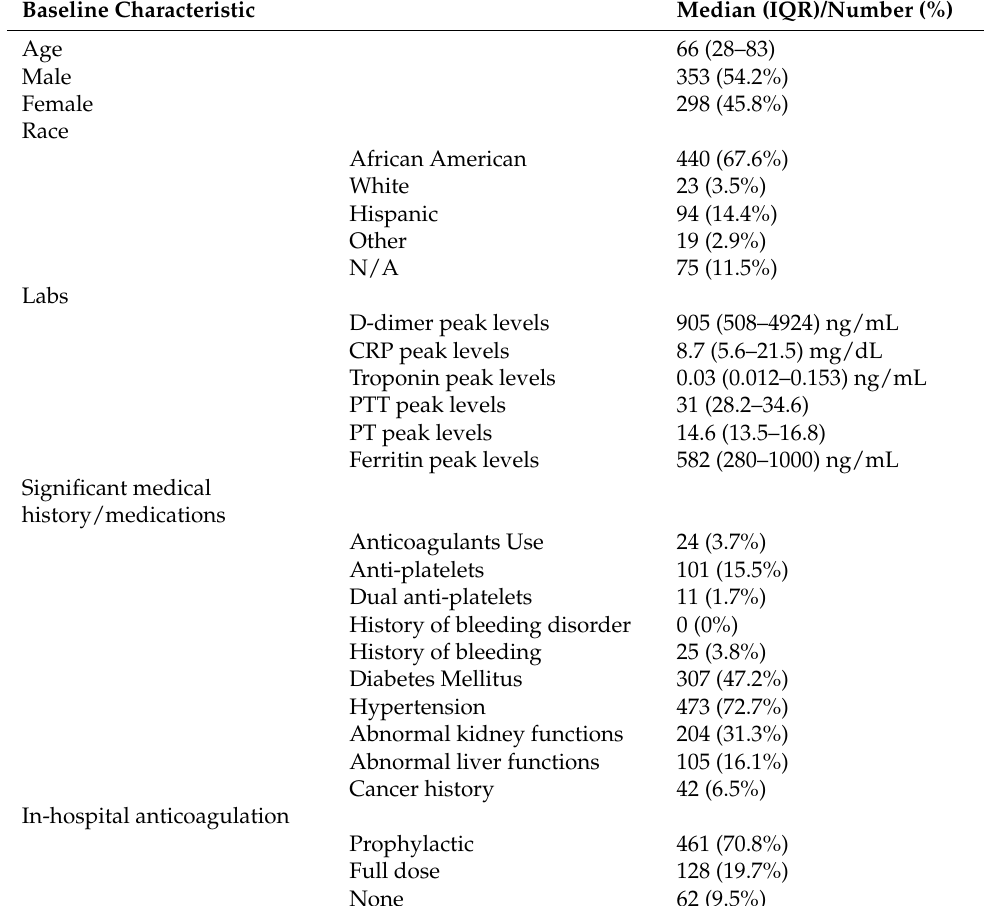
Table 1. Baseline characteristics of 651 patients admitted to Brookdale